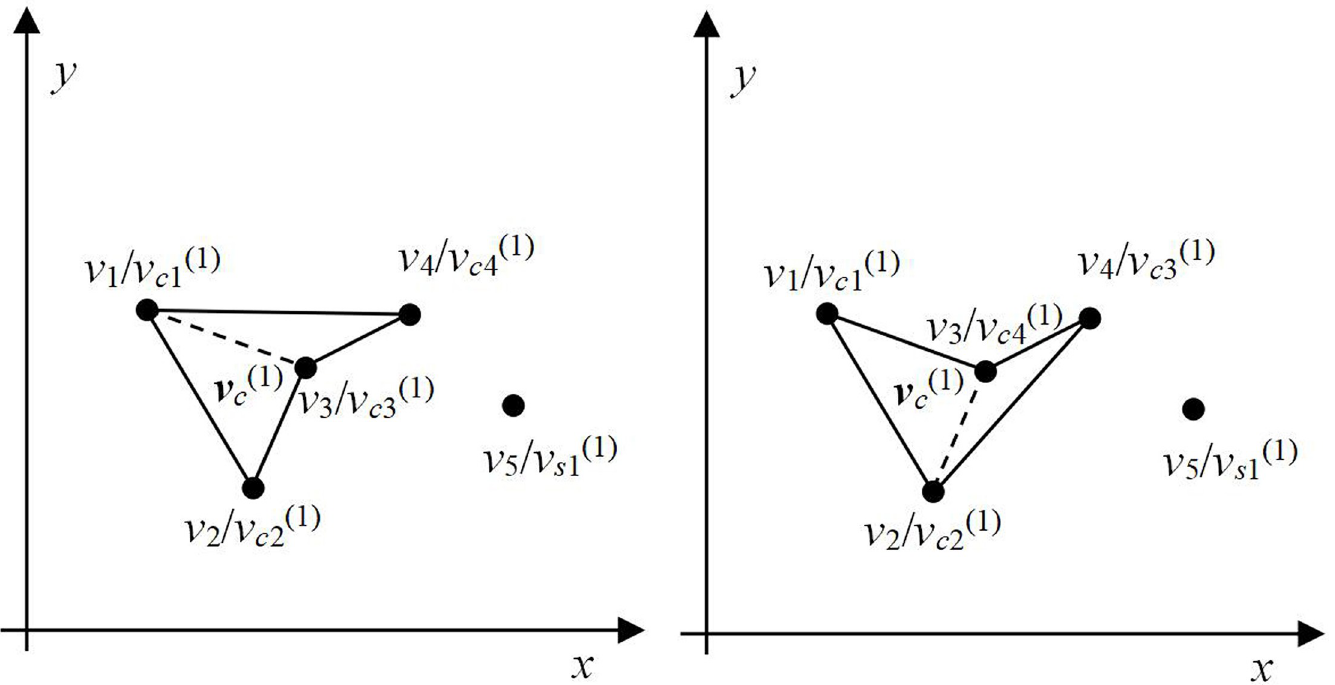
Fig 6. New polygon after one iteration. (a) Polygon 1 and (b) polygon 2.